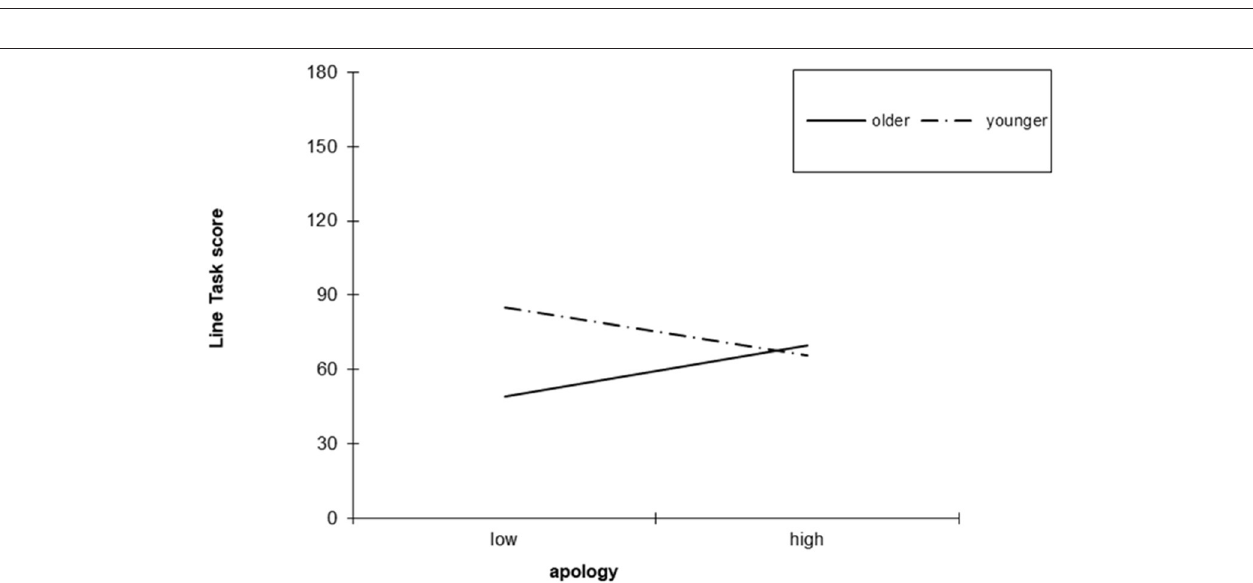
FIGURE 3 | Interaction between apology and age in predicting the Line Task, Study 1.